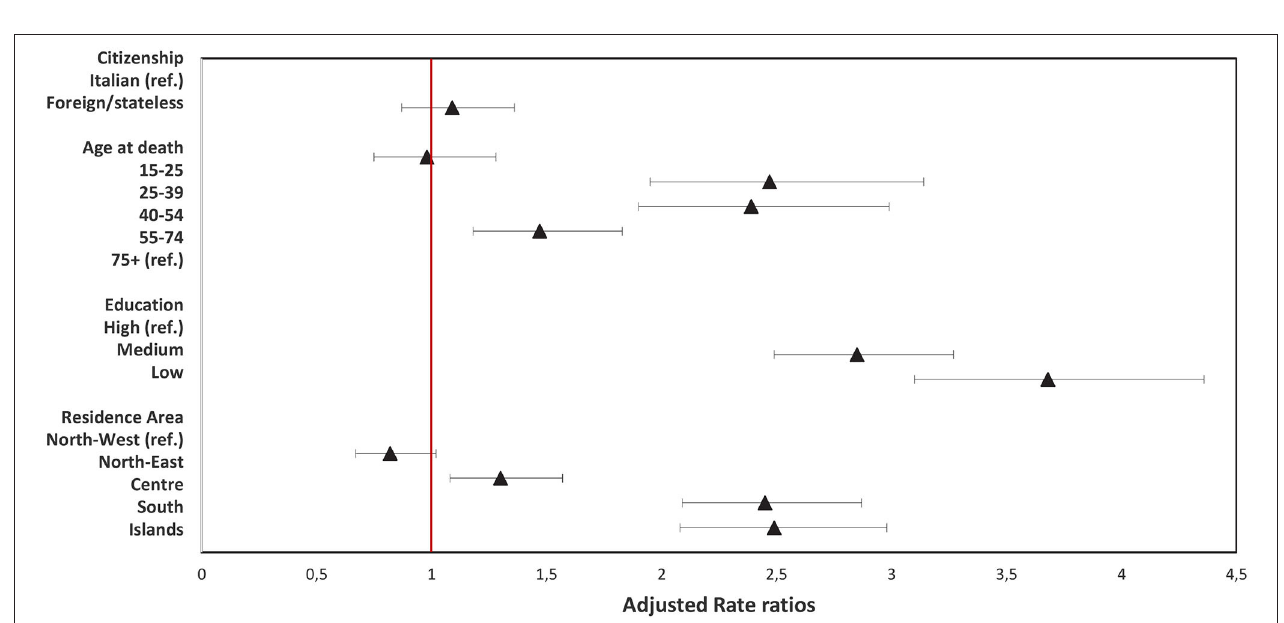
FIGURE 2 | Results of multivariate quasi-Poisson regression model (Males). 75 years, and higher mortality risk was also observed in females with a medium or low education level, compared with those with a high level (RRadj: 1.38; 95% CI: 1.17–1.62). A slight protective effect of the macro area of residence was observed for females residing in the South of Italy (RRadj: 0.82; 95% CI: 0.70– 0.96, South vs. North-West). The results show a significantly different pattern for males, for whom homicide mortality was